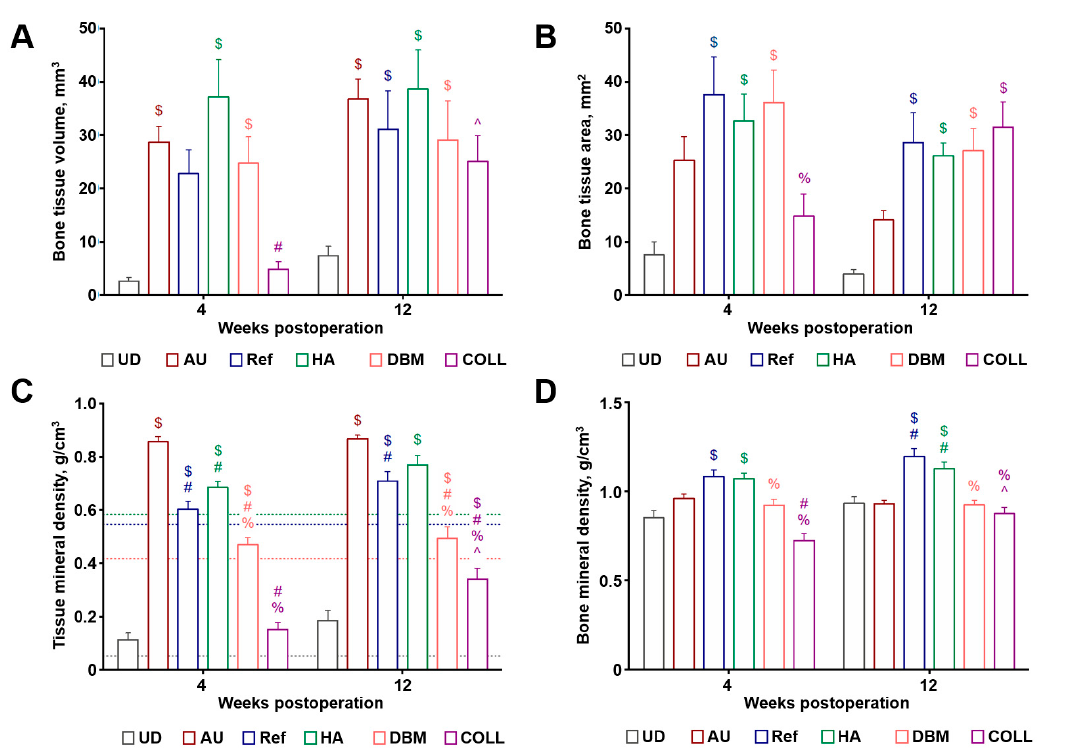
Figure 3. Evaluation of bone repair features upon the implantation of bovine-derived HA, DBM, and COLL into a critical-sized (8 mm diameter) rat calvarial defect in a short- and long-term. Microcomputed tomography measurements of ( A ) bone tissue volume; ( B ) bone tissue area; ( C ) tissue mineral density; and ( D ) bone mineral density. Unfilled defect, autograft, and Geistlich Bio-Oss® represent a negative control, positive control, and reference product, respectively. N = 12 animals per group, one-way analysis of variance with Tukey’s multiple comparisons test. UD—unfilled defect,